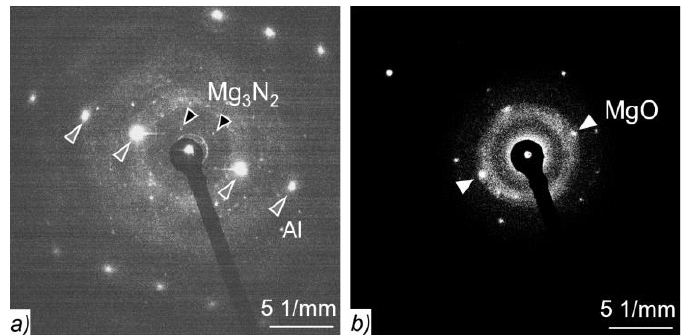
Figure 8. Diffraction patterns of: ( a ) Mg 3 N 2 , and ( b ) MgO from analysis in the upper part of the AlN layer.